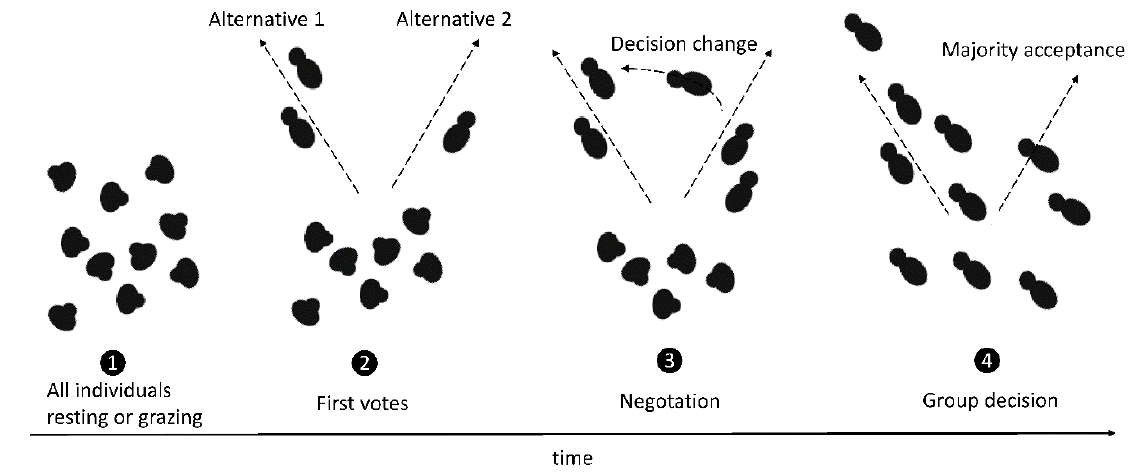
Figure 3: Steps of a voting process in